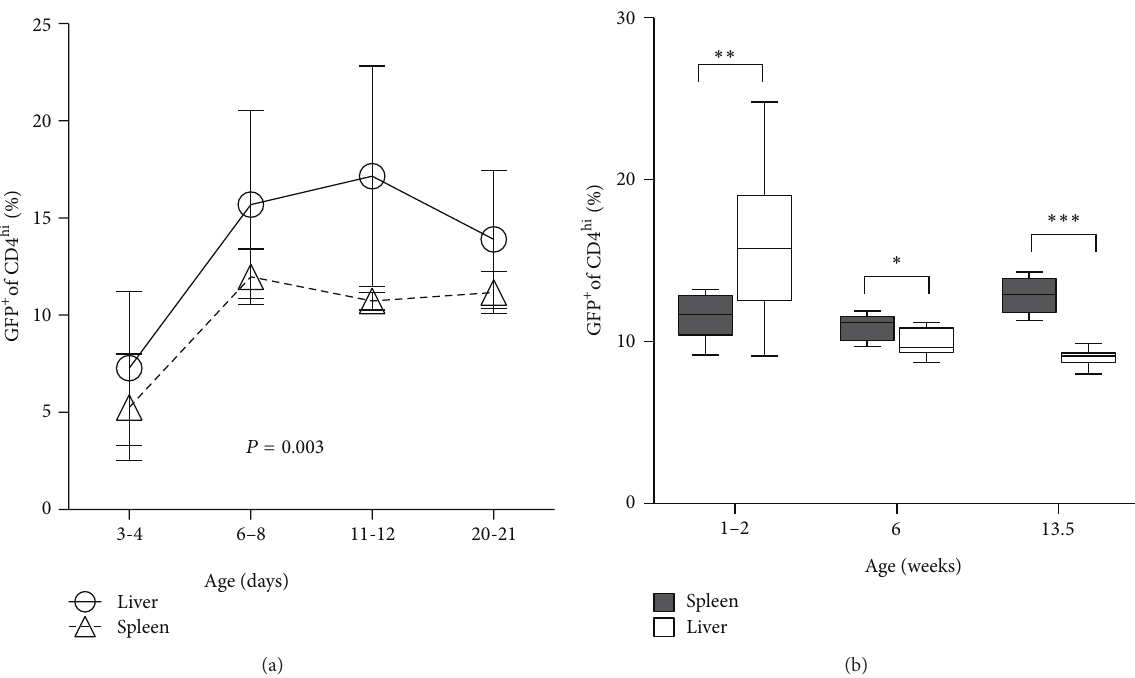
Figure 3: The increased frequency of FoxP3 + CD4 + cells in postnatal liver reverses in the adult. (a) Liver and spleen FoxP3 + CD4 + frequency data from BALB/c-background FoxP 3 EGFP mice prior to weaning are displayed. Statistical analysis was by 2-way ANOVA. (b) FoxP3 + CD4 + frequency data from preweaned mice (age 1-2 weeks) and adult mice (age 6 weeks; age 13.5 weeks) are shown. For 1-2 weeks, data for 6- to 8-day-old mice were combined with data from 11- to 12-day-old mice. 𝑁 = 7 to 12 mice per time point. Statistical analyses used the nonparametric Mann-Whitney